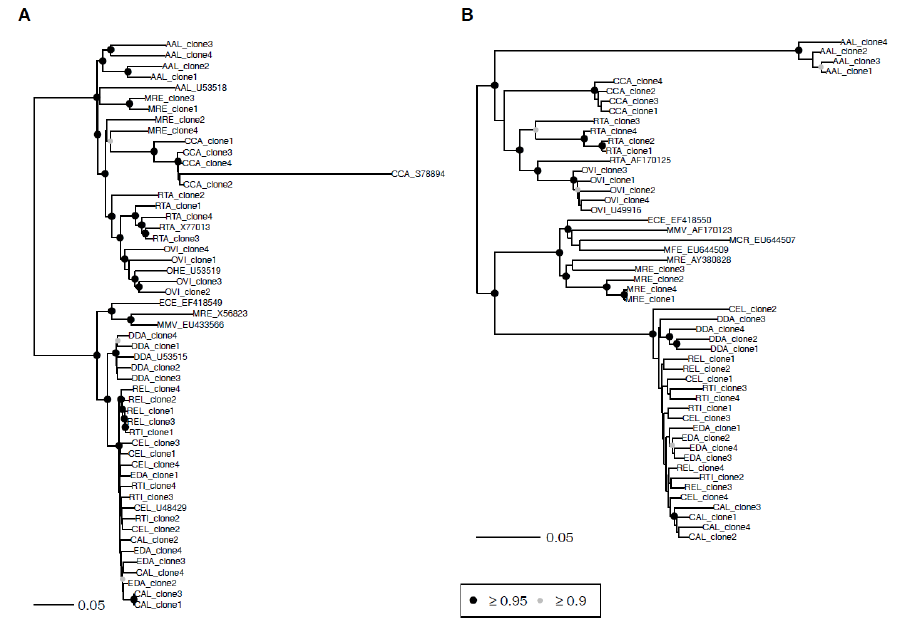
Figure 2. Bayesian phylogenetic trees constructed from cervid satellite sequences. (A) SatI and